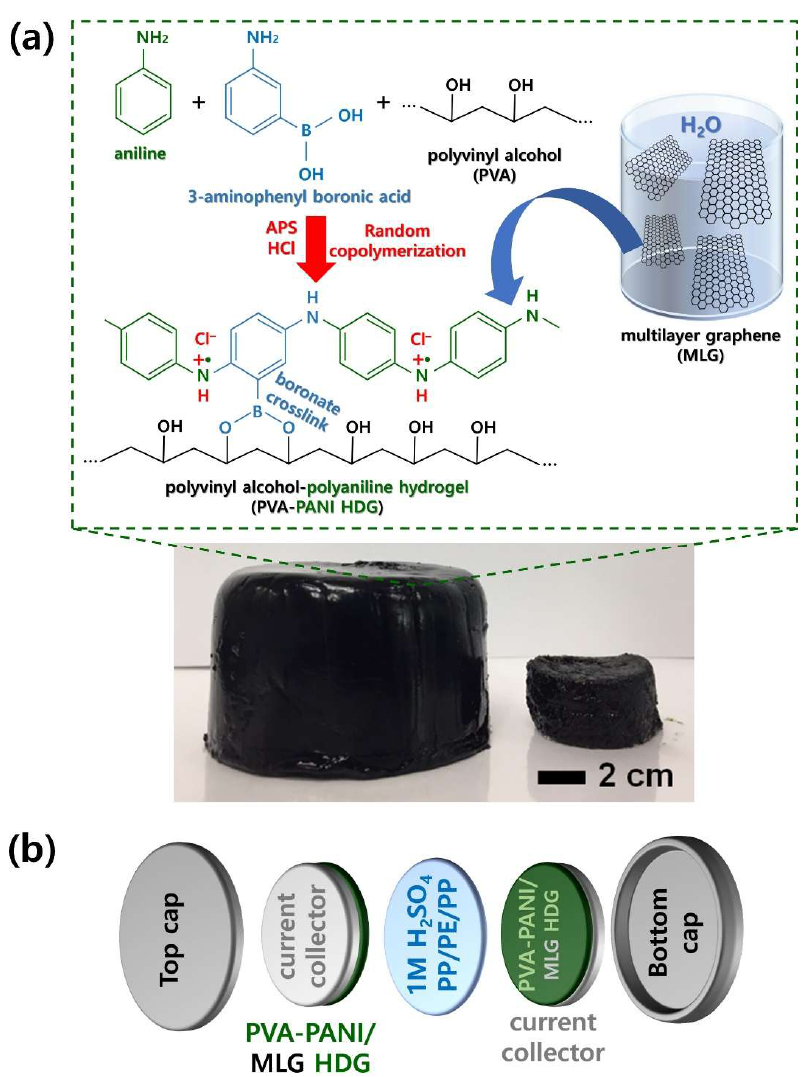
Figure 2. ( a ) Overall synthetic route for producing PVA – PANI – MLG HDG with tunable scalability. ( b ) Schematic illustration for a coin cell supercapacitor assembled with PVA – PANI – MLG HDG as ( b ) Schematic illustration for a coin cell supercapacitor assembled with PVA–PANI–MLG HDG as electrode materials. electrode